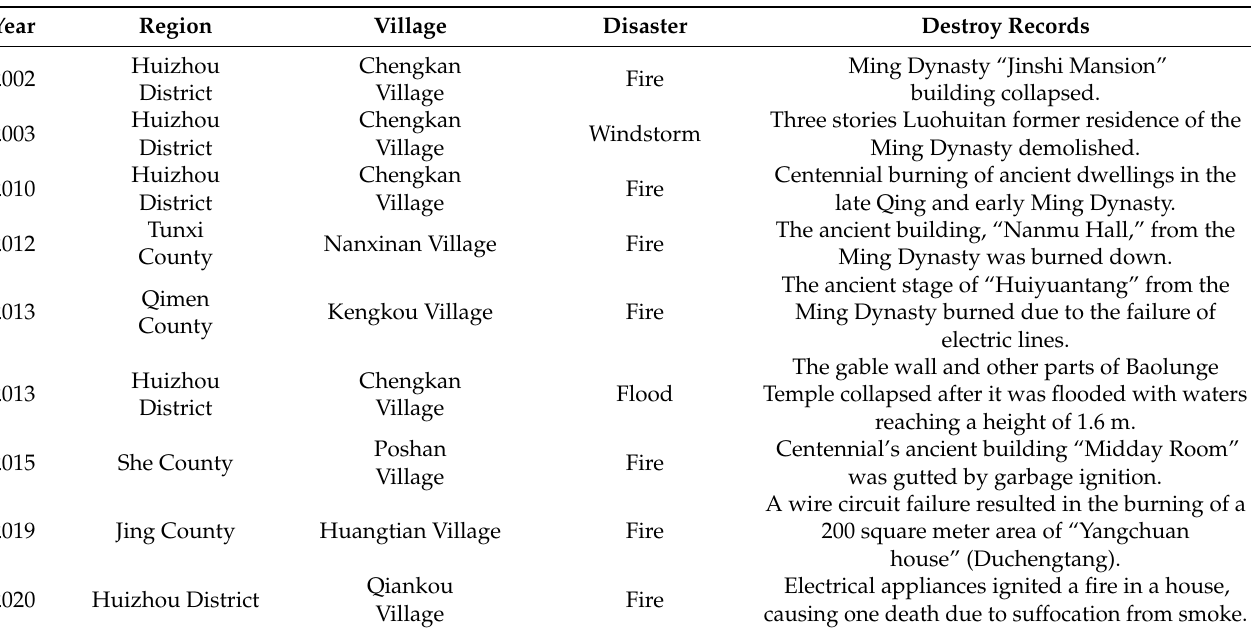
Table 1. Disasters in the heritage villages in Huizhou culture core region from 2000 to